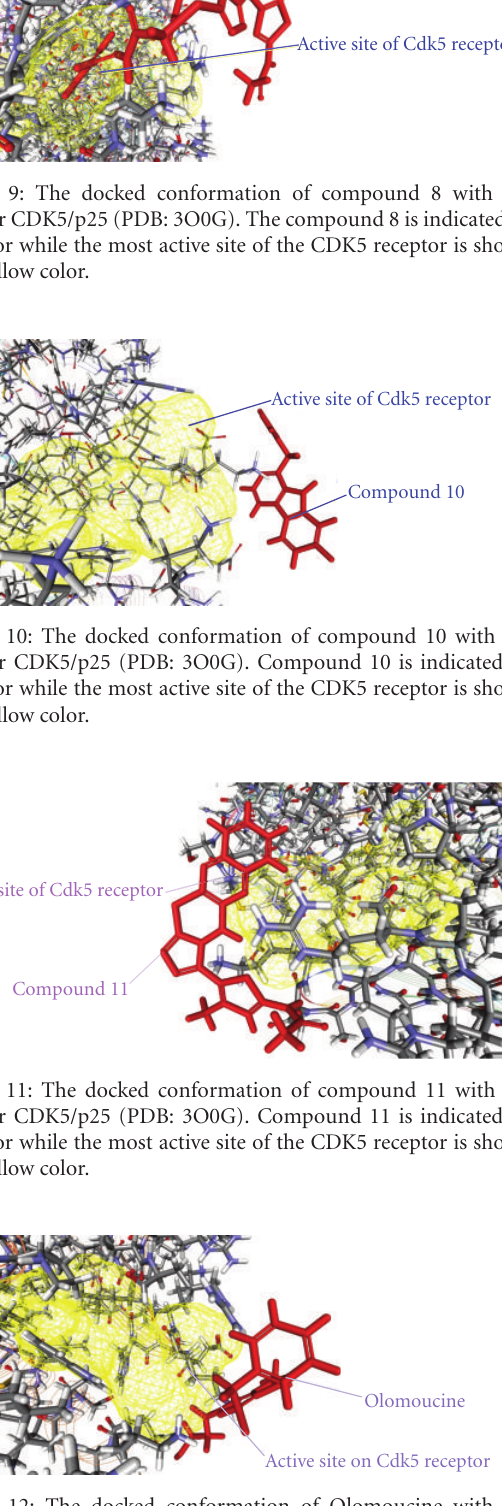
Figure 12: The docked conformation of Olomoucine with the receptor CDK5/p25 (PDB: 3O0G). The Olomoucine is indicated by red color while the most active site of the CDK5 receptor is shown with yellow color.